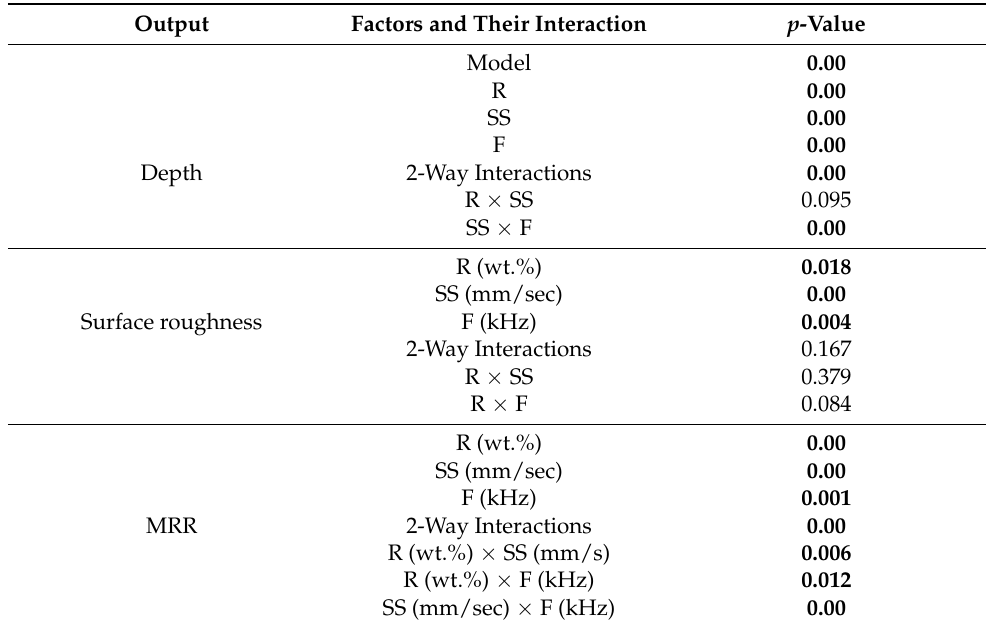
Table 5. ANOVA results for output responses.